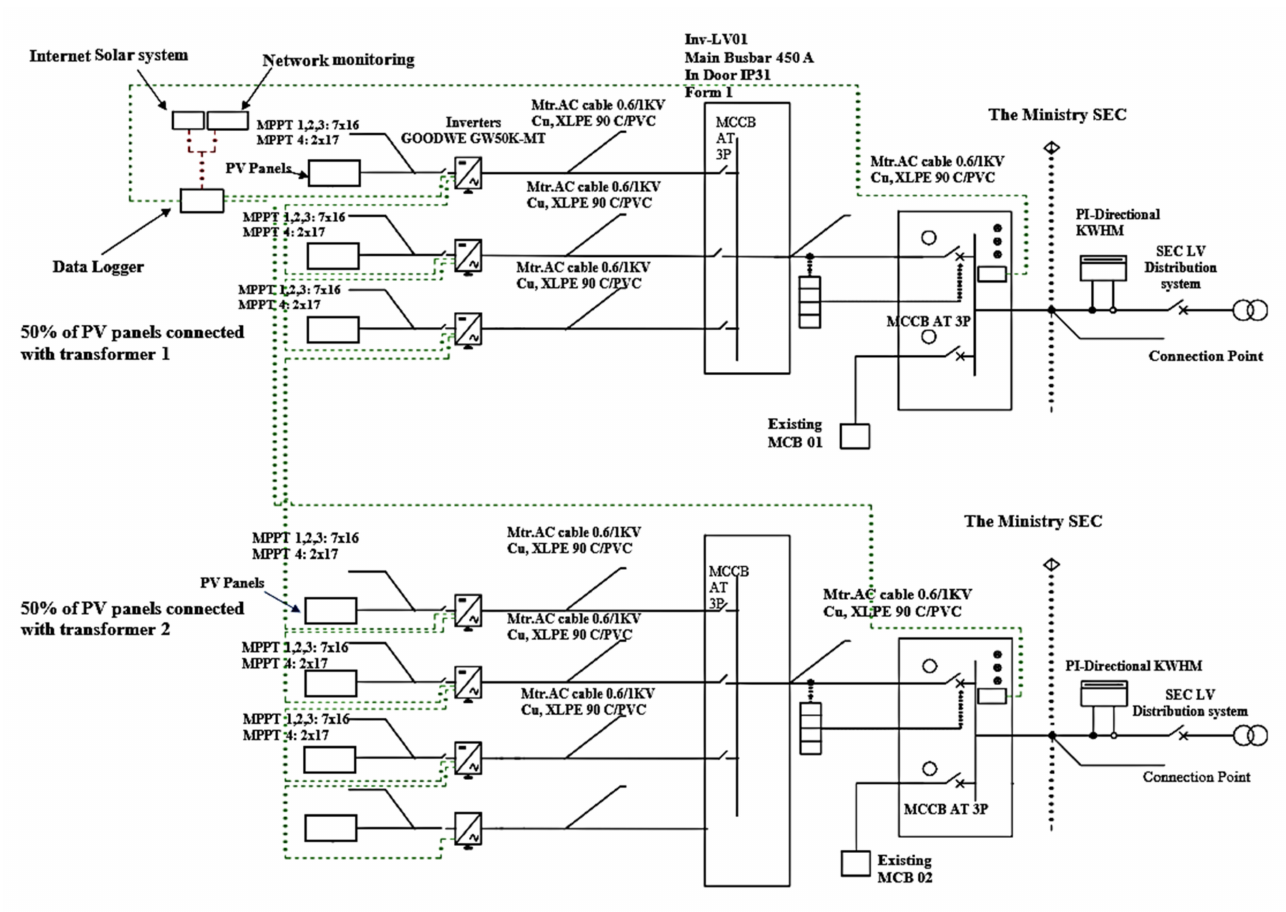
Figure 10. Single-line diagram of the entire